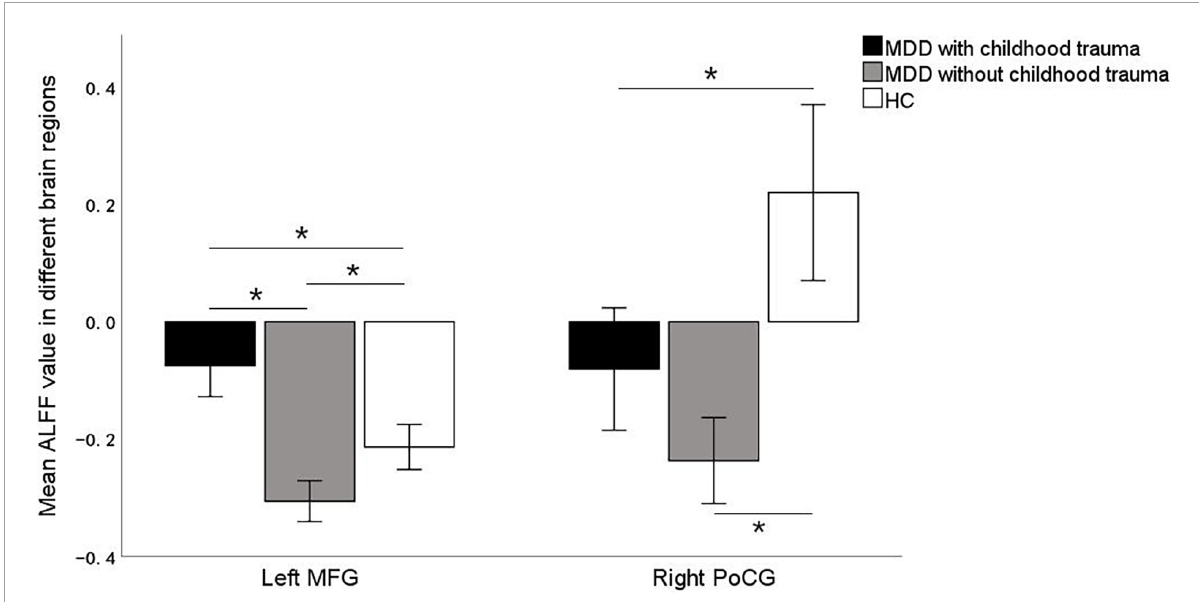
FIGURE2 Post hoc two samplet—tests were used to determine the between groups differences in ALFF value in left middle frontal gyrus and right postcentral gyrus showing significant differences in ALFF maps in the previous ANOVA. *Bonferroni correction with P < 0.025 was set for significance. MFG, middle frontal gyrus; PoCG, postcentral gyrus.